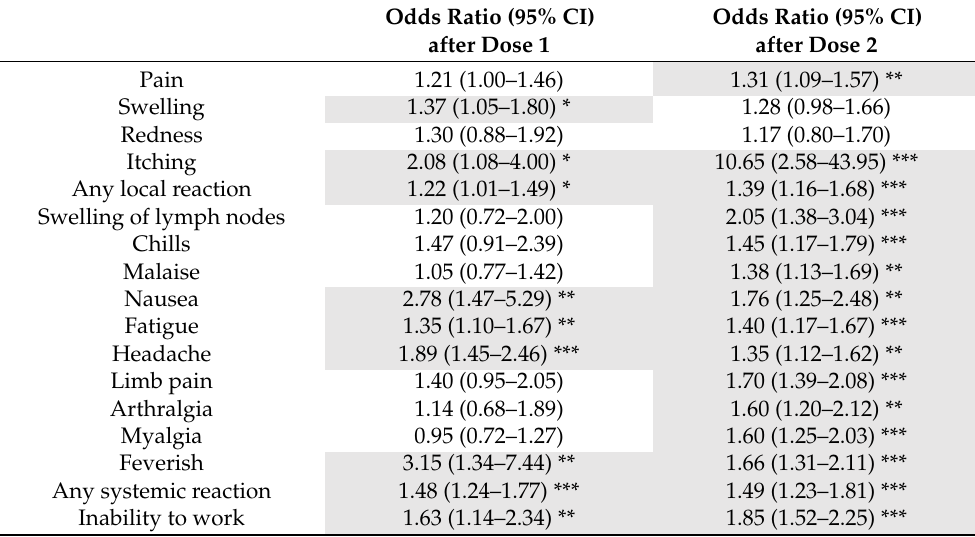
Table 2. Odds ratio of adverse effects after first and second dose of BNT162b2 mRNA vaccine comparing female to male